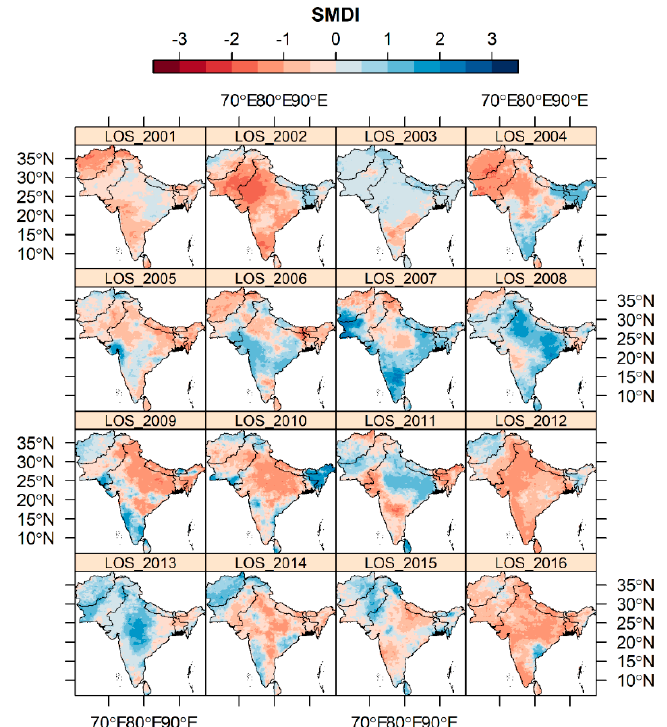
Figure 10. The spatial pattern of SMDI over South Asia during LOS phenology stage from 2001–2016.